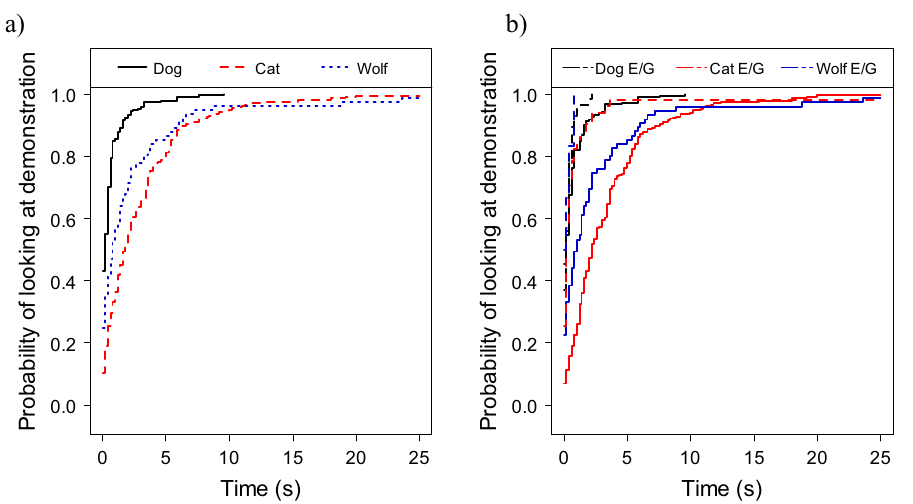
Figure 3. ( a ) Species differences: dog puppies were more likely to look at the demonstration than wolves and kittens and ( b ) species-specific effects of condition (experimental condition, E, illustrated with solid, and ghost condition, G, with dotted line) on the probability of looking at the demonstration: dog puppies looked at the demonstration in both, experimental and ghost trials; kittens and wolves looked more at the demonstration in the ghost trials than in the experimental trials, with this difference being more pronounced in